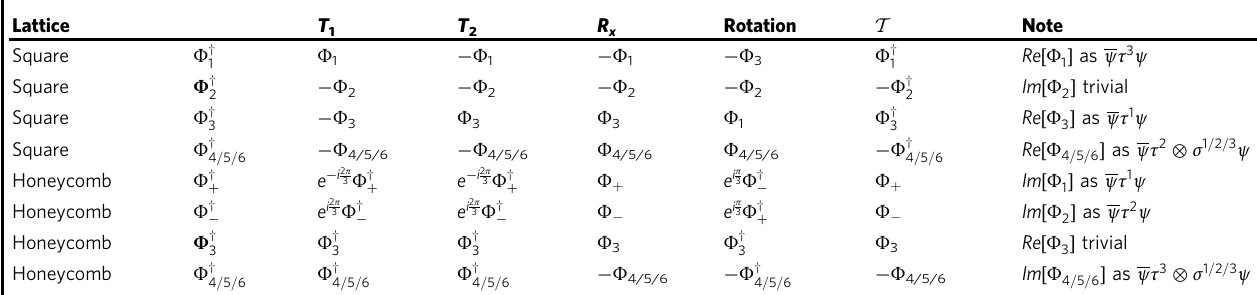
Symmetry operations T 1/2 , R x denote translation along two lattice vectors (for honeycomb T 1/2 direction has 2 π /3 angle between them) and re fl ection along horizontal bonds, respectively. Rotation implies site centered four-fold rotation for the square lattice and hexagon centered six-fold rotation for the honeycomb. There is always a trivial monopole (highlighted in bold) for DSLs on both these bipartite lattices. On proliferating the trivial monopole the emergent symmetry is reduced from U (1) top ×SO(6) → SO(5), and the 15 SO(6) adjoint fermion bilinears spilt according to 5 + 10. The fi ve fermion bilinears, which form an SO(5) vector, are now symmetry equivalent to fi ve monopoles, as listed in the last column, which is relevant to the chiral symmetry breaking pattern described in the discussion of Eq.